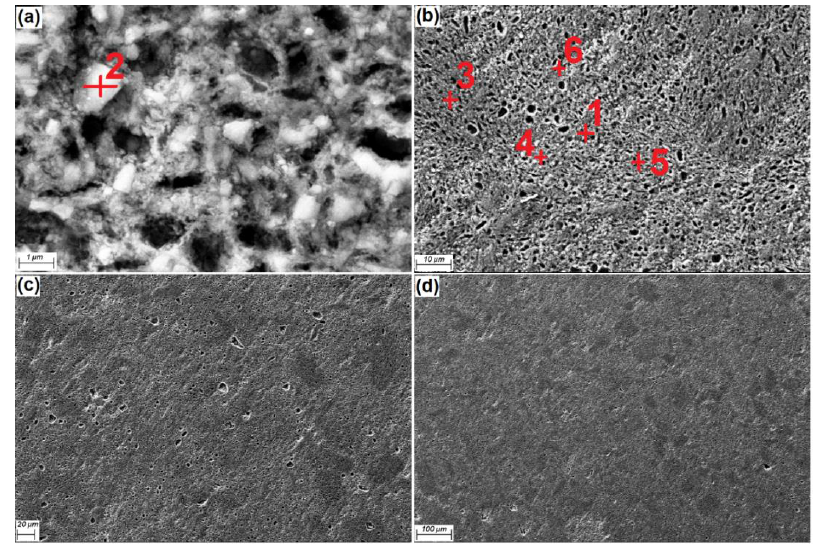
Figure 4. FESEM micrographs of Al-30Fe 3 O 4 -20SiC composite, in different magnifications, after etching ( a ) 1 m scale, ( b ) 10 m scale, ( c ) 20 m scale and ( d ) 100 m scale.